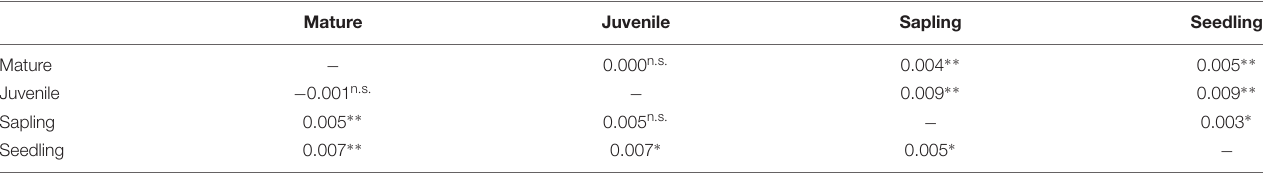
TABLE 2 | Pairwise differentiation between four growth stages using F ST from AMOVA using 11 and 6 loci.